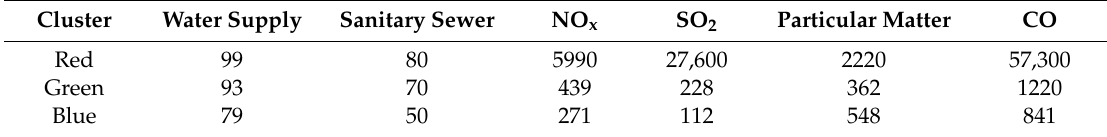
Table 4. Centroids of clusters.